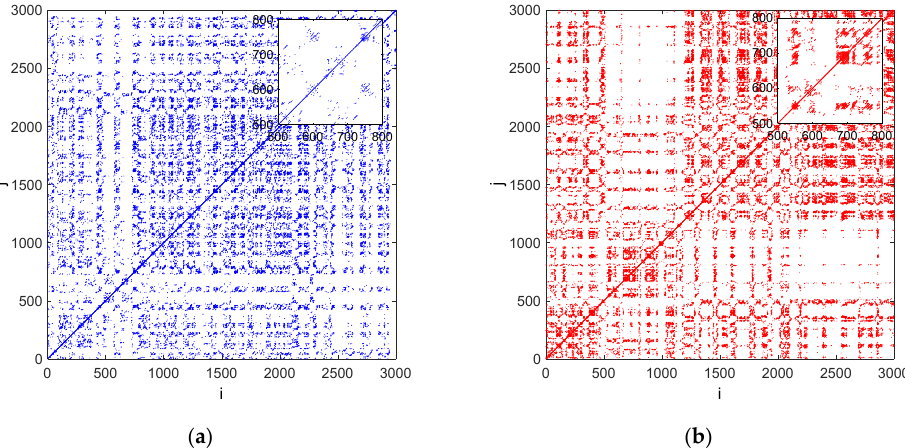
Figure 6. Recurrence plots showing the cutting force in drilling CFRP without defect ( a ) and with defect ( b ). The calculations were made for constant ε = 0.5.